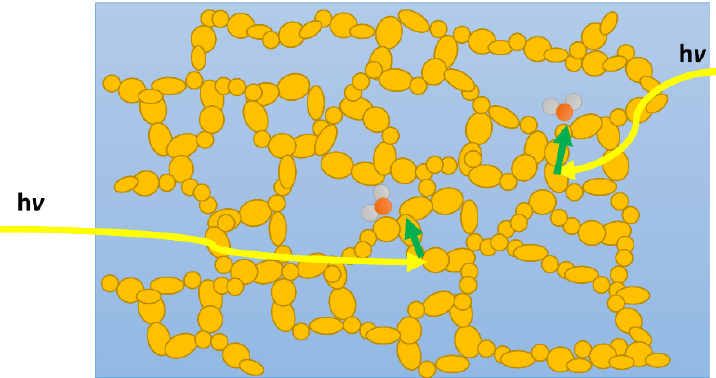
Figure 24. The internal surface area of porous materials potentially provides an interface for the photocatalyst and the aqueous environment. Porous materials have increased interfaces, thus no dead volume and a larger number of accessible active sites.